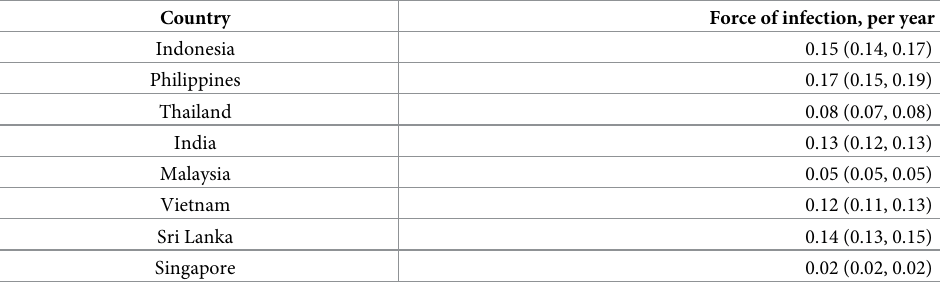
Force of infection in parenthesis shows 95% confidence intervals derived using the profile likelihood method.